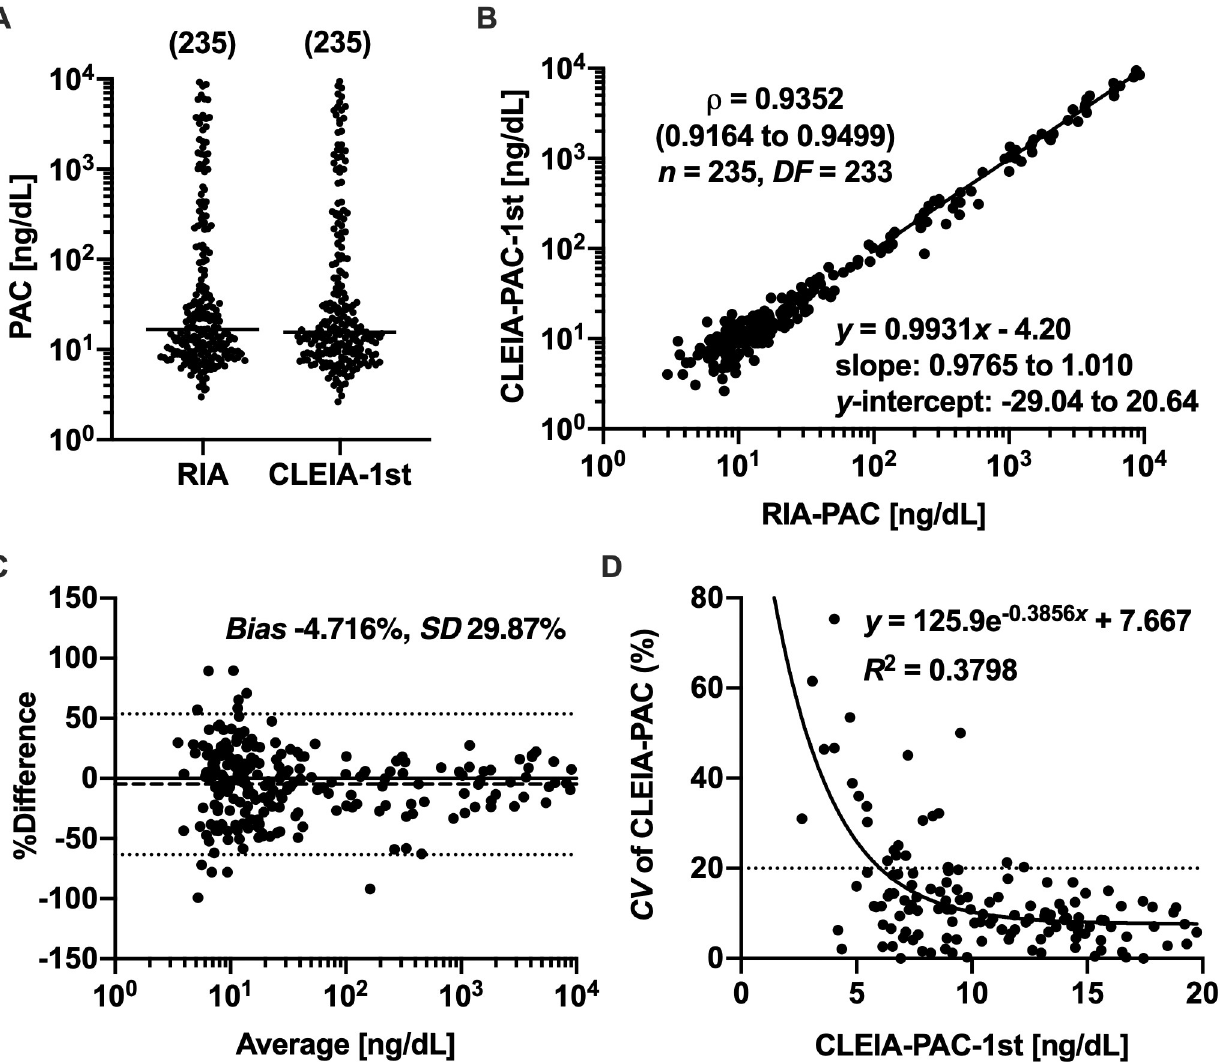
Fig 3. Comparisons between CLEIA-PAC-1st and RIA-PAC values. (A) The distributions of RIA-PAC and CLEIA-PAC values in the first assays (CLEIA-PAC-1st). Medians are indicated by horizontal bars and sample numbers are shown in parentheses. (B) Spearman’s rank correlation and linear regression analyses between CLEIA-PAC-1st and RIA-PAC values. Spearman’s correlation coefficient ( ρ ) is shown with the 95% CI in a parenthesis and the degree of freedom ( DF ). The equation of linear regression line is also shown with the 95% CIs of slope and y -intercept. (C) The Bland-Altman plot between CLEIA-PAC-1st and RIA-PAC values. The percent values of (CLEIA-PAC-1st—RIA-PAC)/(the average of CLEIA-PAC-1st and RIA-PAC) (%Difference) are plotted against the averages of CLEIA-PAC-1st and RIA-PAC values, and the bias and 95% limits of agreement are indicated with dashed and dotted lines, respectively. The bias and standard deviation ( SD ) of %Difference are also shown. (D) The relation between the coefficient of variation ( CV ) of CLEIA-PAC values and CLEIA-PAC-1st values. The CV of 20% is indicated by a dotted line.